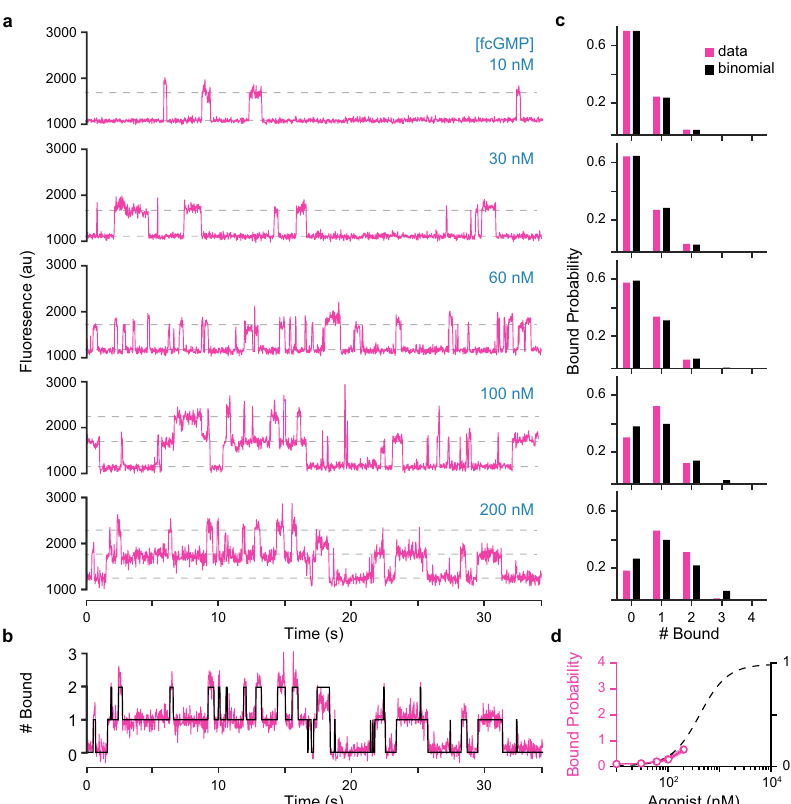
Fig. 4 Concentration-dependent fcGMP binding. a Time series for fcGMP binding to single TAX-4 containing nanovesicles at increasing concentrations of fcGMP. Horizontal dashed lines indicate approximate fl uorescence levels re fl ecting stepwise binding of one or two fcGMP molecules. Fluorescence is in arbitrary units (au). b Idealization (black) of fl uorescence (magenta) time series for the number of bound fcGMP at an individual molecule in 200 nM fcGMP (see “ Methods ” section). c Bound probability distributions for all tested concentrations and fi ts to a binomial distribution assuming four identical and independent sites. Bound probability [95% CI] per site from the binomial fi ts: 10 nM = 0.08 [0.079, 0.081], 30 nM = 0.10 [0.09, 0.11], 60 nM = 0.12 [0.10, 0.14], 100 nM = 0.21 [0.20, 0.22], 200 nM = 0.26 [0.24, 0.28]. d Average fcGMP bound probability across all molecules and normalized ionic current 46 as a function of fcGMP or cGMP concentration, respectively. Shaded area represents SEM (partially hidden by the line width). Current values are for fi ts of the Hill equation to inside-out patch clamp recordings in Komatsu et al. 46 . Source data are provided as a Source Data fi